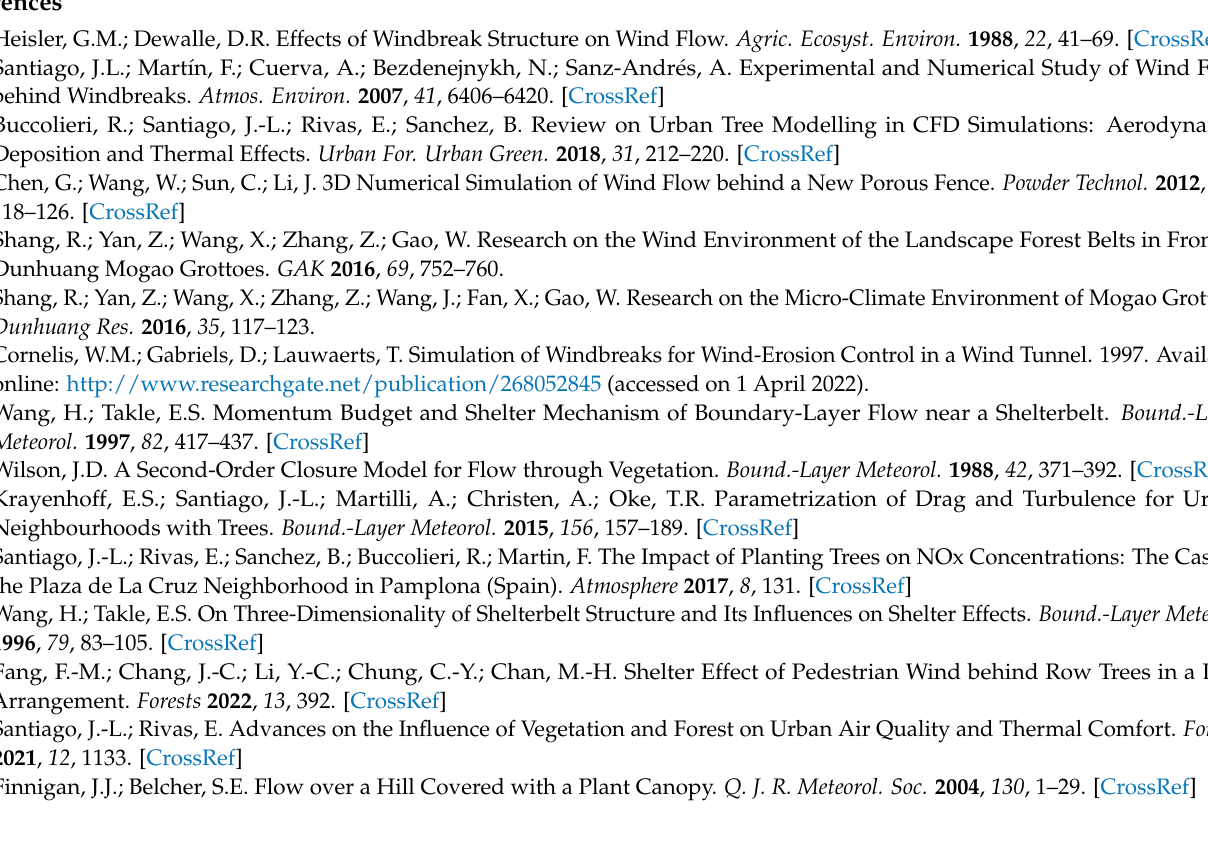
Figure A2. Comparison of simulated and measured profiles of mean wind speed and turbulent kinetic energy at position of x/H = −5 [41].